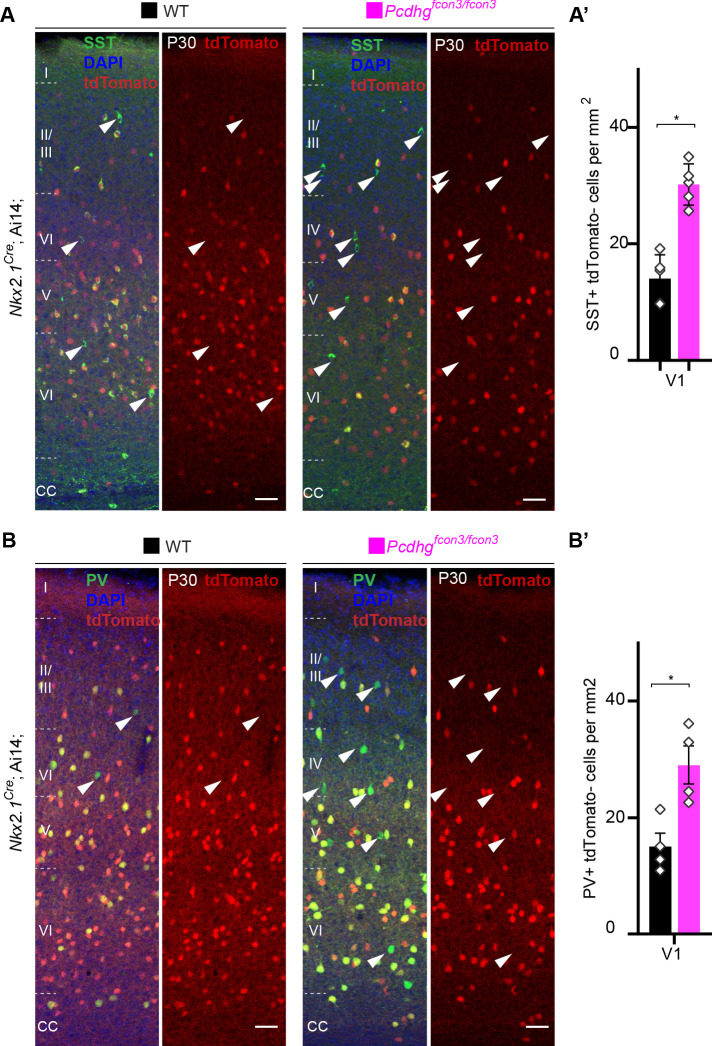
Increased survival of non-Nkx2.1-derived SST and PV cINs in Pcdhg-deficient mice.(A,B) Representative photographs of the primary visual cortex (V1) in Nkx2.1Cre;Ai14;Pcdhg+/+ (Pcdhg WT) and Nkx2.1Cre;Ai14;Pcdhgfcon3/fcon3 (Pcdhg mutant) mice at P30. Sections were stained for SST and PV. Arrowheads (in A and B) indicate SST+ or PV+ unrecombined (tdTomato-) cINs. Scale bar 50 μm. (A’, B’) Quantifications of SST+/tdTomato- (A) and PV+/tdTomato- (B) cells in V1 of Pcdhg WT and Pcdhg mutant mice at P30 (Mann-Whitney test, for SST+/tdtomato- *p=0.0079, n = 5 mice of each genotype; for PV+/tdTomato- *p=0.0.0286, n = 4 mice of each genotype).
Figure 3—figure supplement 4—source data 1.Quantification of non-Nkx21-derived PV and SST positive cINs in the visual cortex of controls and Pcdhg loss of function mice.